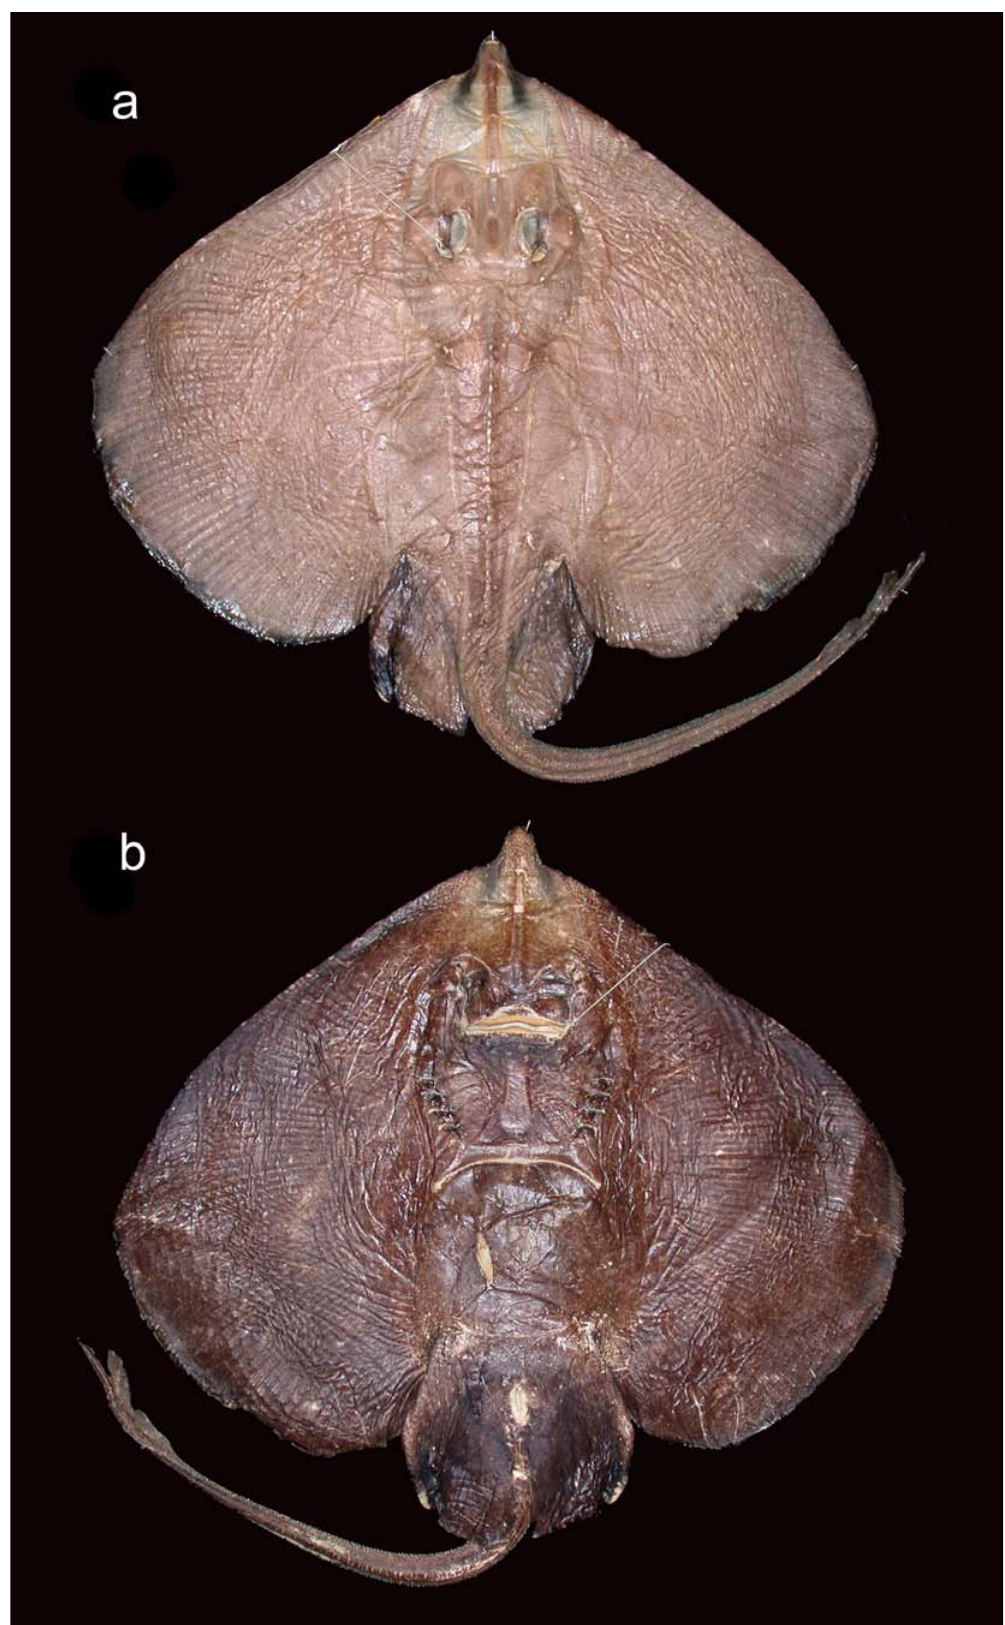
Fig. 1. Holotype of Malacoraja obscura , n. sp. (MNRJ 28289, 680 mm TL) in dorsal (a) and ventral (b)